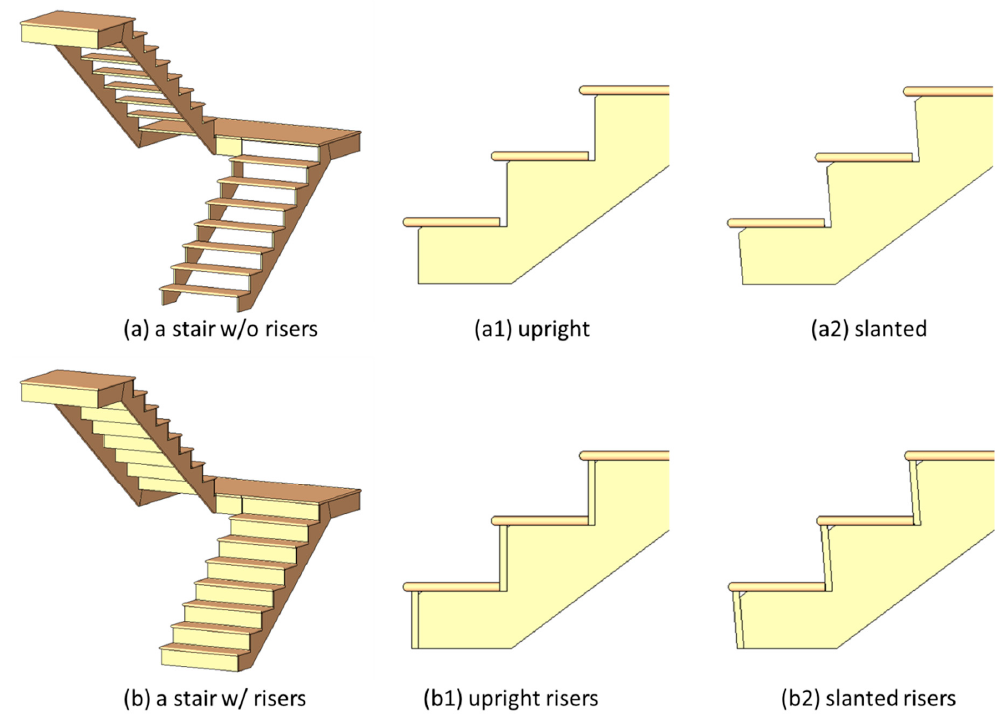
Figure 8. Stairs with risers.